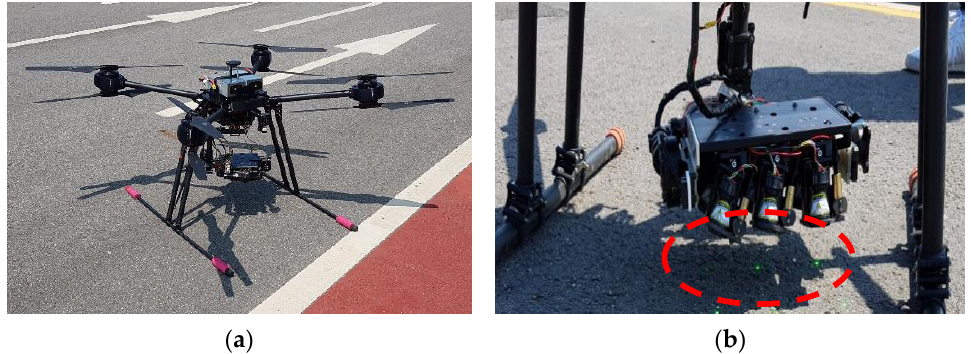
Figure 9. This is a developed drone for vehicle detection a lane: ( a ) drone with detection sensor part; ( b ) drone VDM indicating in the red circle.